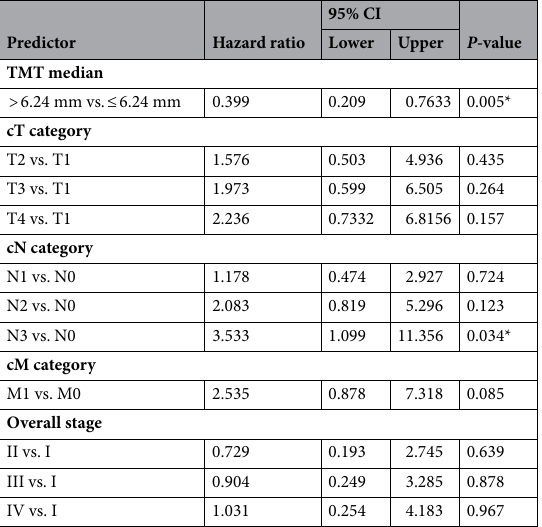
Table 3. Multivariable analysis of progression-free survival. CI confidence interval, TMT temporalis muscle thickness, cT clinical tumor, cN clinical node, cM clinical metastasis. * P value less than 0.05 indicates statistical significance.